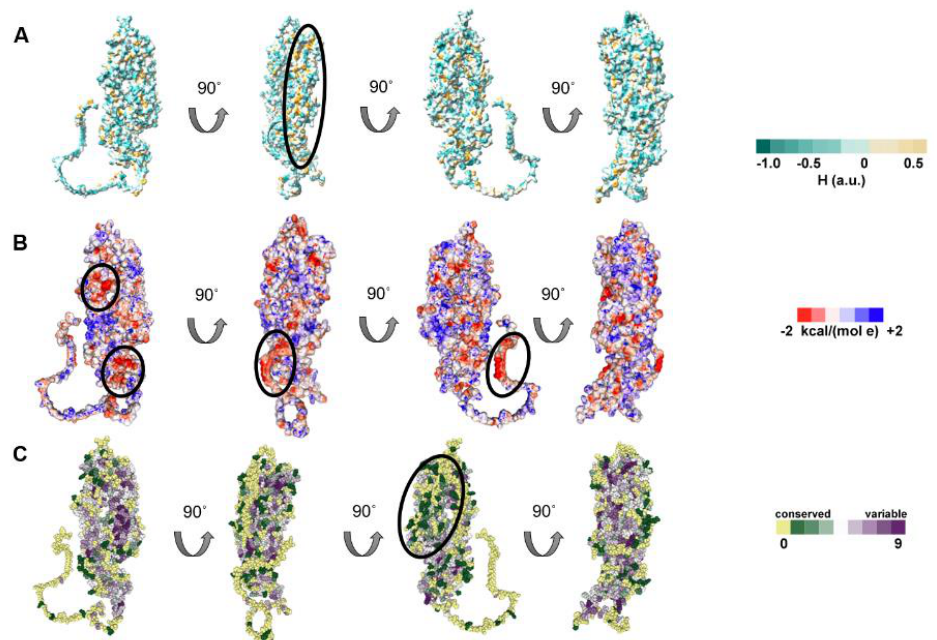
Figure 4. Surface analysis of HSV-1 UL37. ( A ) Hydrophobicity of HSV–1 UL37. HSV–1 UL37 tegument protein is predominantly hydrophilic with hydrophobic pockets. ( B ) Electrostatic potential of HSV–1 UL37. Negatively charged prominences are encircled. ( C ) Conservation analysis of HSV–1 UL37. HSV–1 UL37 consists of a conserved core and variable surface (encircled).